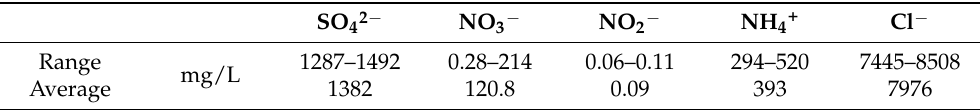
Table 2. Range and average of the most important parameters determined for the wet flue gas desulphurization (WFGD) wastewater streams used in this